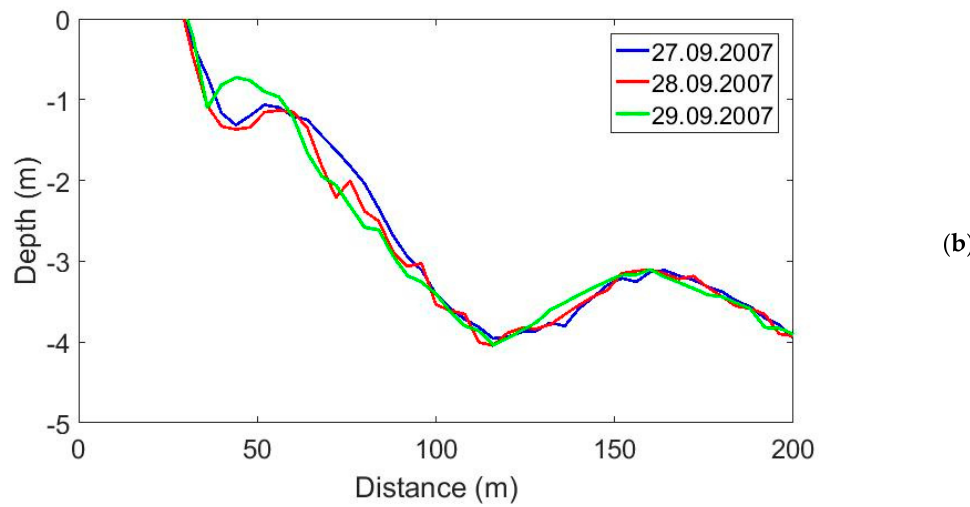
Figure 2. Sea bottom evolution from 14:00 on 27 September until 29 September 2007 (morning) ( a ) and corresponding daily averaged profiles ( b ).